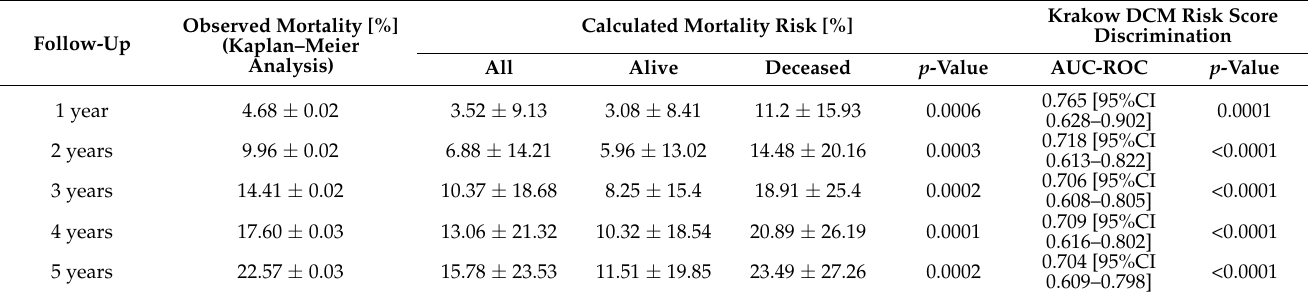
Table 2. Krakow DCM Risk Score mortality rates observed and predicted at 1, 2, 3, 4 and 5